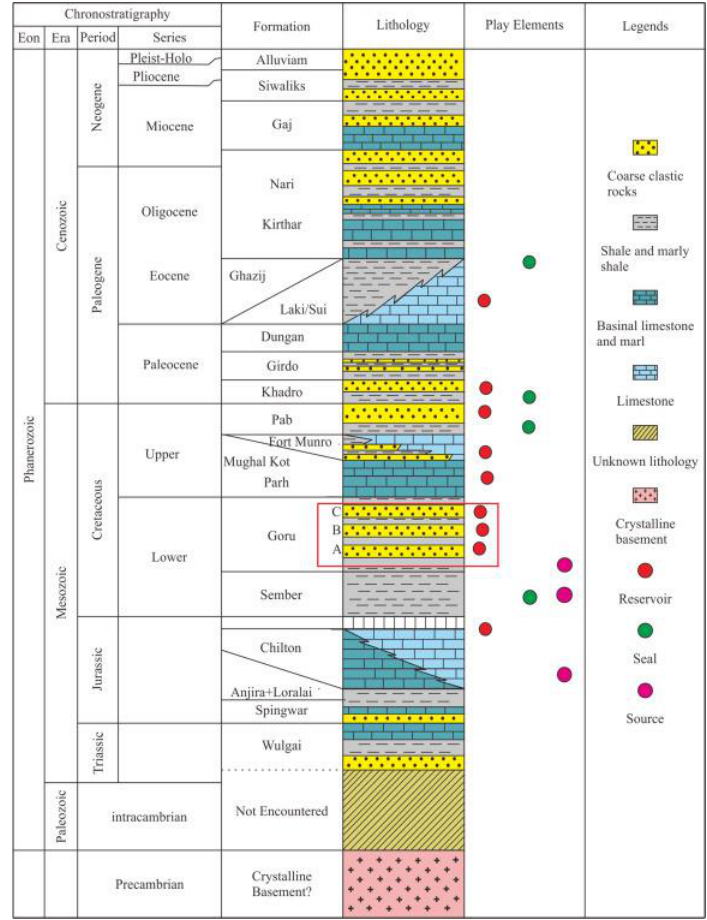
Figure 2. Stratigraphic column of Indus Basin. The tight gas reservoir and the conventional gas reservoir both develop in the B sand in Lower Goru, Cretaceous (cited from [5]).